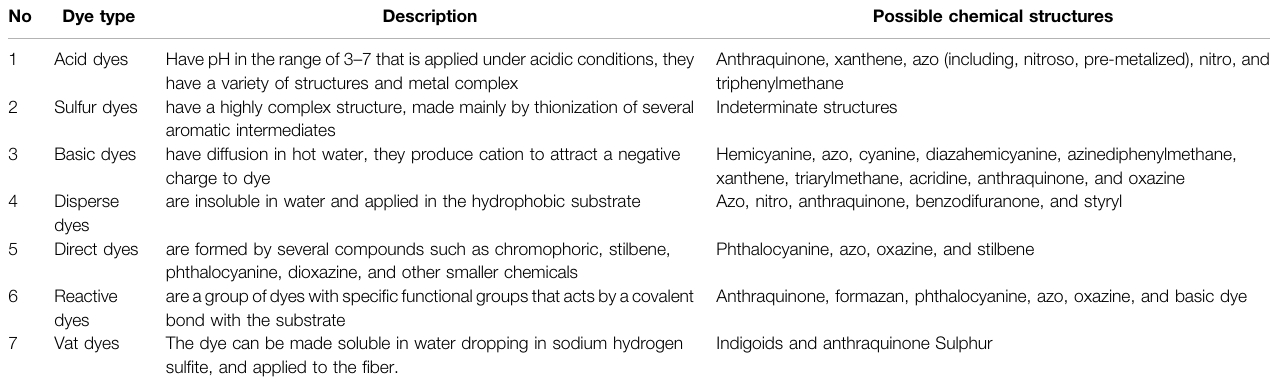
TABLE1| Somecommonclassi fi cationsofdyesbasedontheirchemicalcompositionorapplication.Adoptedwithmodi fi cationfrom(RaufandSalmanAshraf,2012;Shah, 2019; Giovanella et al., 2020; Ihsanullah et al.,